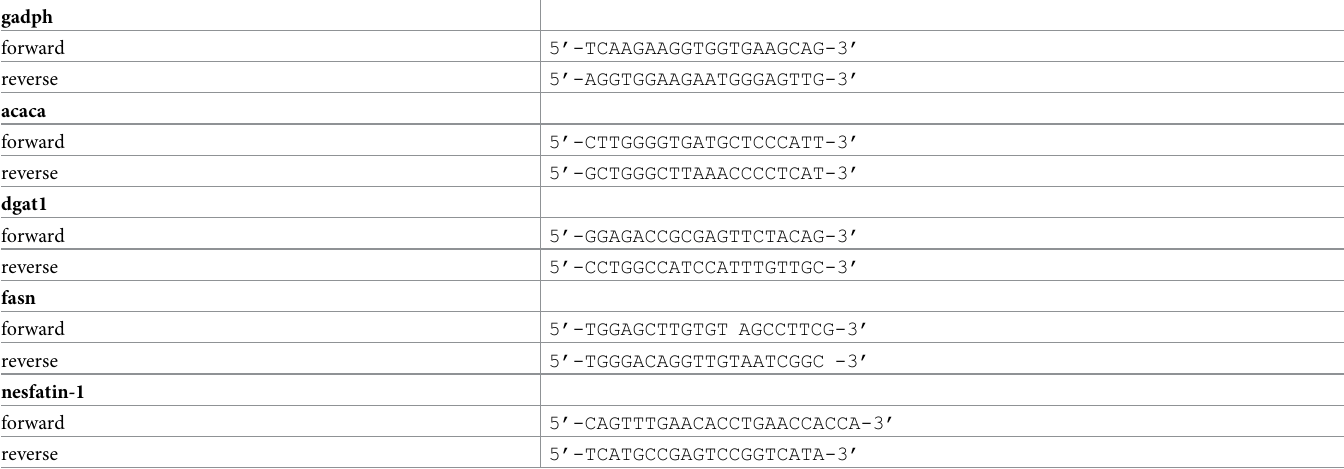
Table 2. Details of the